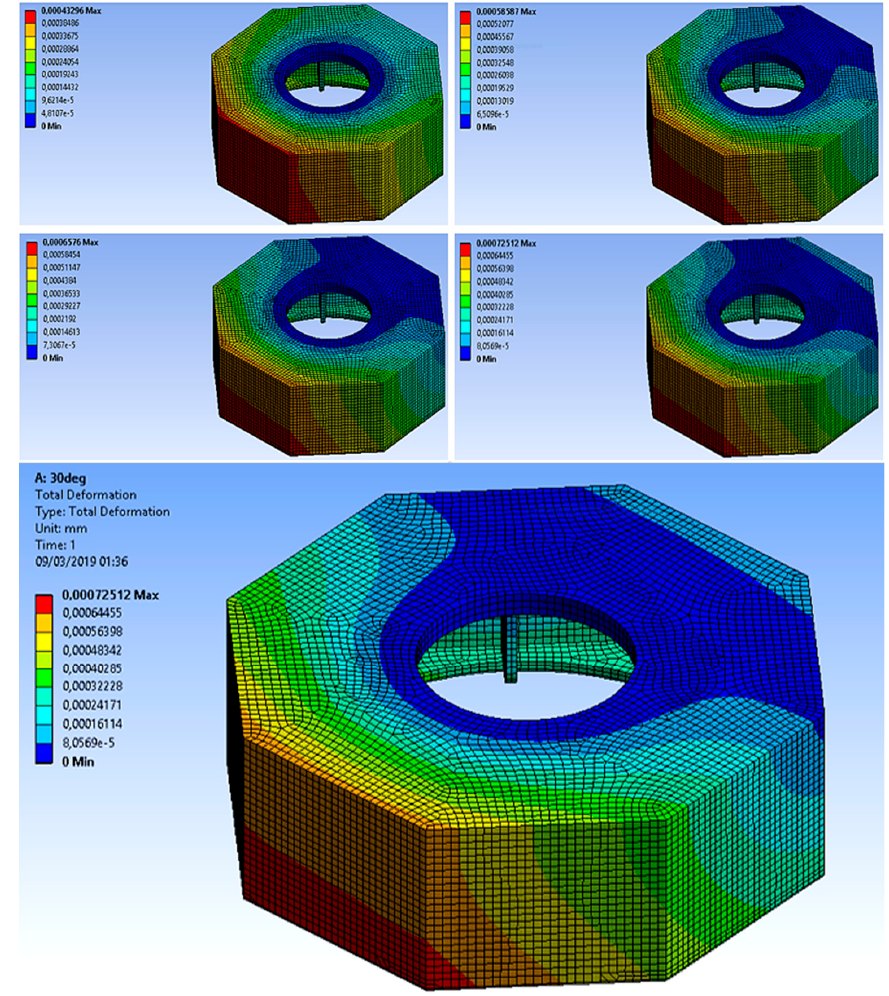
Figure 5. Total deformation of the octagonal platform as predicted by the FEM at various tilt angles (from top left to bottom right 𝛼 = 10°,15°,20°,25° and 30°).